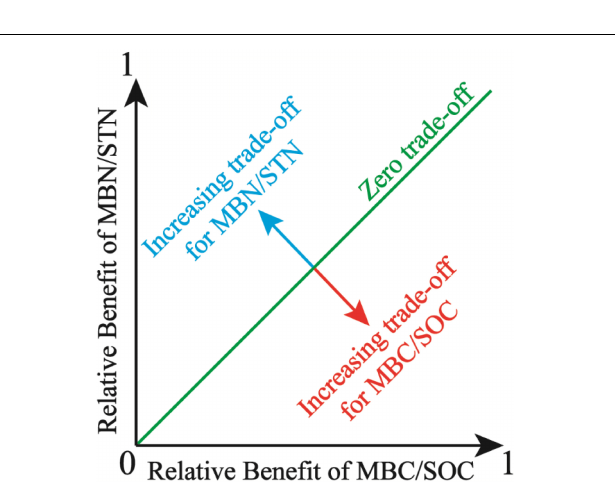
FIGURE 2 | Illustration of the trade-off between microbial entropy carbon (MBC/SOC) and microbial entropy nitrogen (MBN/STN), and the trade-off is calculated as the root mean square error (RMSE) of the individual benefits and increases with distance from the 1:1 line, in which the benefit of MBC/SOC equals the benefit of